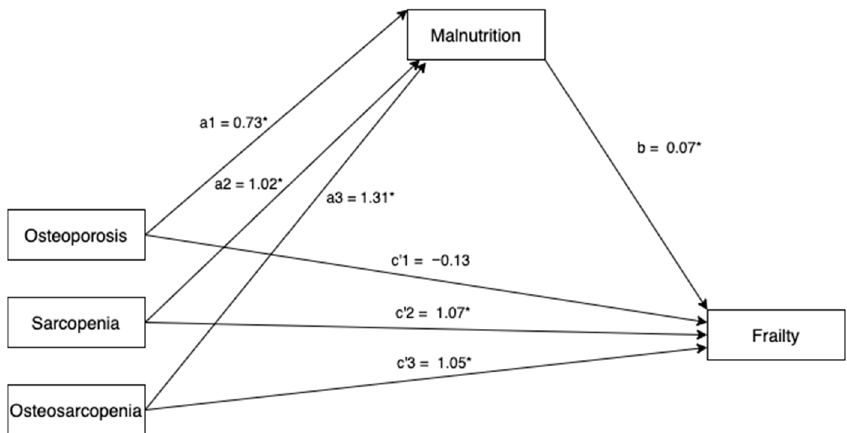
Figure 1. Multicategorical mediation model for total frailty score (* p < 0.05). Paths a1, a2, a3 represent the effect of osteoporosis, sarcopenia and osteosarcopenia on the proposed mediator, malnutrition; path b represents the effect of the proposed mediator, malnutrition on frailty; path c’1, c’2 and c’3 represent the relative direct effect of osteoporosis, sarcopenia and osteosarcopenia on frailty. All paths are represented by unstandardized regression coefficients.